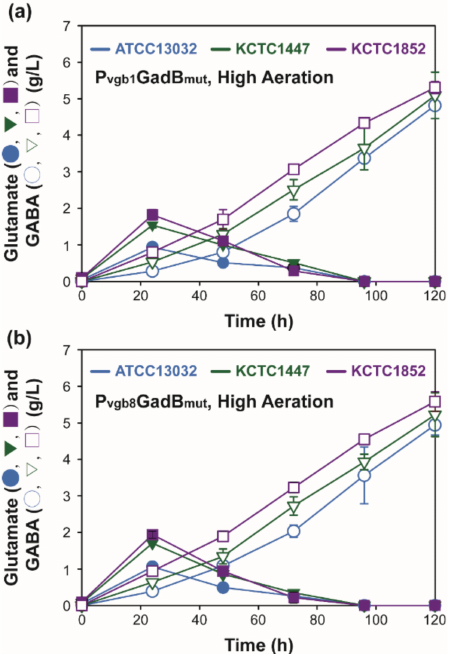
Figure 5. Time profile of Gamma-aminobutyric acid production by recombinant C. glutamcium strains expressing GadB mut under P vgb ( a ) and P vgb8 ( b ) under high aeration